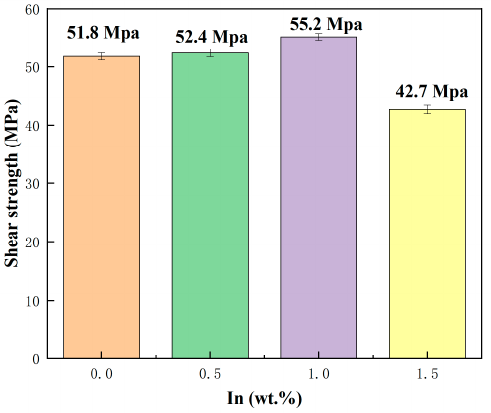
Figure 13. Shear strength of SnBiAg–xIn (x = 0, 0.5, 1.0, 1.5)/Cu soldered joints.